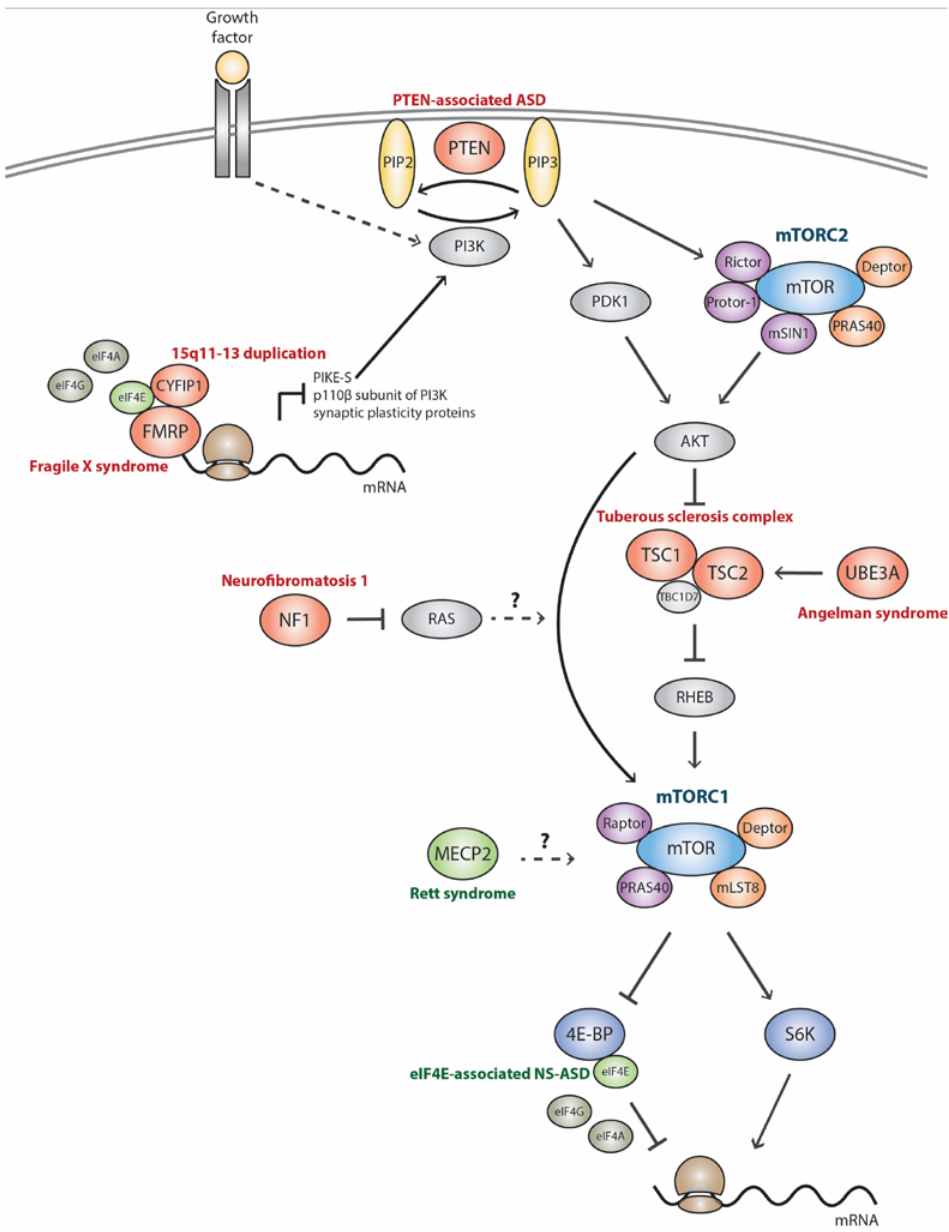
Figure 1. The mechanistic target of rapamycin complex 1 (mTORC1) signaling pathway. mTORC1 signaling components and proteins encoded by genes that inhibit (in red) or enhance (in green) mTORC1 pathway and cause autism spectrum disorder (ASD)-related syndromes and nonsyndromic ASD. Please see Box 1 for further details on mTORC1 signaling pathway. 4E-BP = eIF4E-binding protein; CYFIP1 = cytoplasmic FMR1 interacting protein 1; Deptor = DEP domain-containing mTOR-interacting protein; eIF = eukaryotic initiation factor; FMRP = fragile X mental retardation protein; MECP2 = methyl-CpG binding protein 2; mLST8 = mammalian lethal with SEC13 protein 8; mSIN1 = mammalian stress-activated protein kinase interacting protein 1; NF1 = neurofibromatosis 1; PDK1 = 3-phosphoinositide-dependent protein kinase 1; PI3K = phosphoinositide 3-kinase; PIKE = phosphoinositide 3-kinase enhancer; PIP = phosphatidylinositol; PRAS40 = proline-rich AKT substrate of 40 kDa; Protor-1 = protein observed with Rictor-1; PTEN = phosphatase and tensin homolog; Raptor = regulatory-associated protein of mTOR; RHEB = Ras homolog enriched in brain; Rictor = rapamycin-insensitive companion of mTOR; S6K = S6 kinase; TSC = tuberous sclerosis complex; UBE3A = ubiquitin-protein ligase E3A.